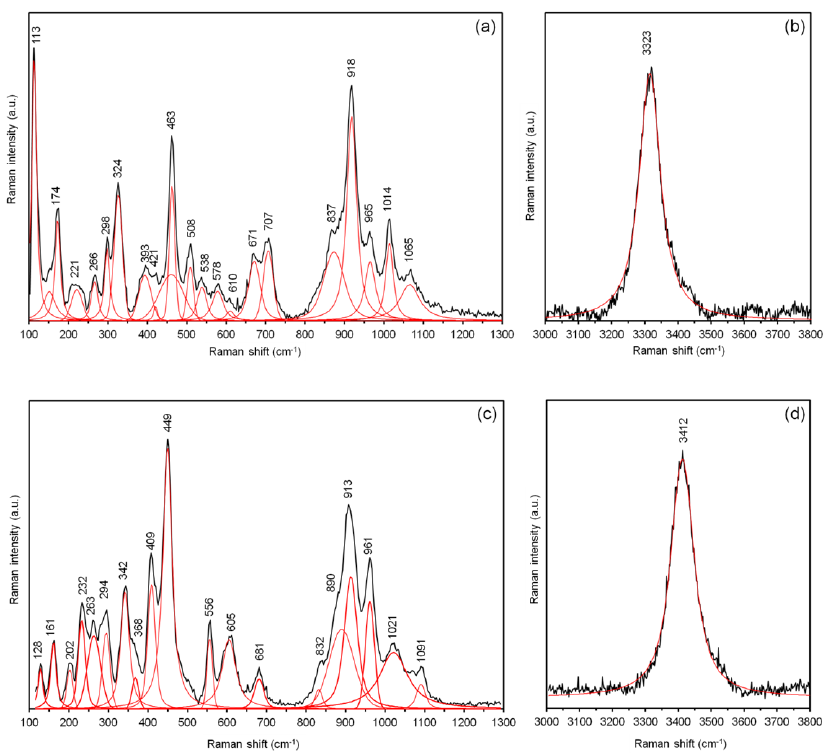
Figure 4. Raman spectra of zoisite-(Pb) (above) and hancockite (below), in the range 100–1300 cm − 1 ( a – c ) and between 3000–3800 cm − 1 ( b – d ). The fitted Raman bands, in red, as well as their Raman shift positions are shown.